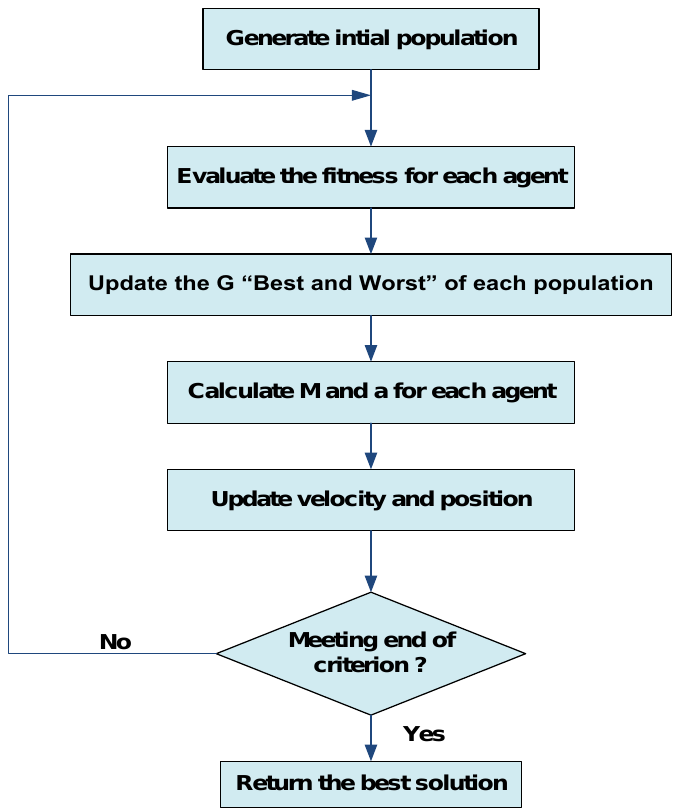
Figure 3. The flowchart of the Gravitational Search Algorithm (GSA).